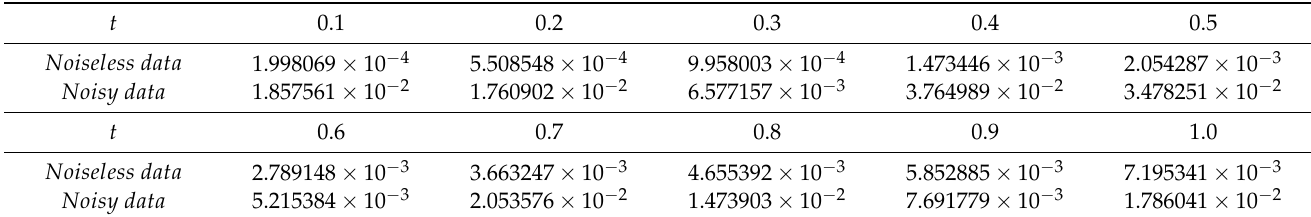
Table 3. Integro-differential equation of Example 2: maximum absolute error E ∞ at some time nodes, where ∆ t = 0.01, where experiments are performed with noiseless data and noisy data, respectively.